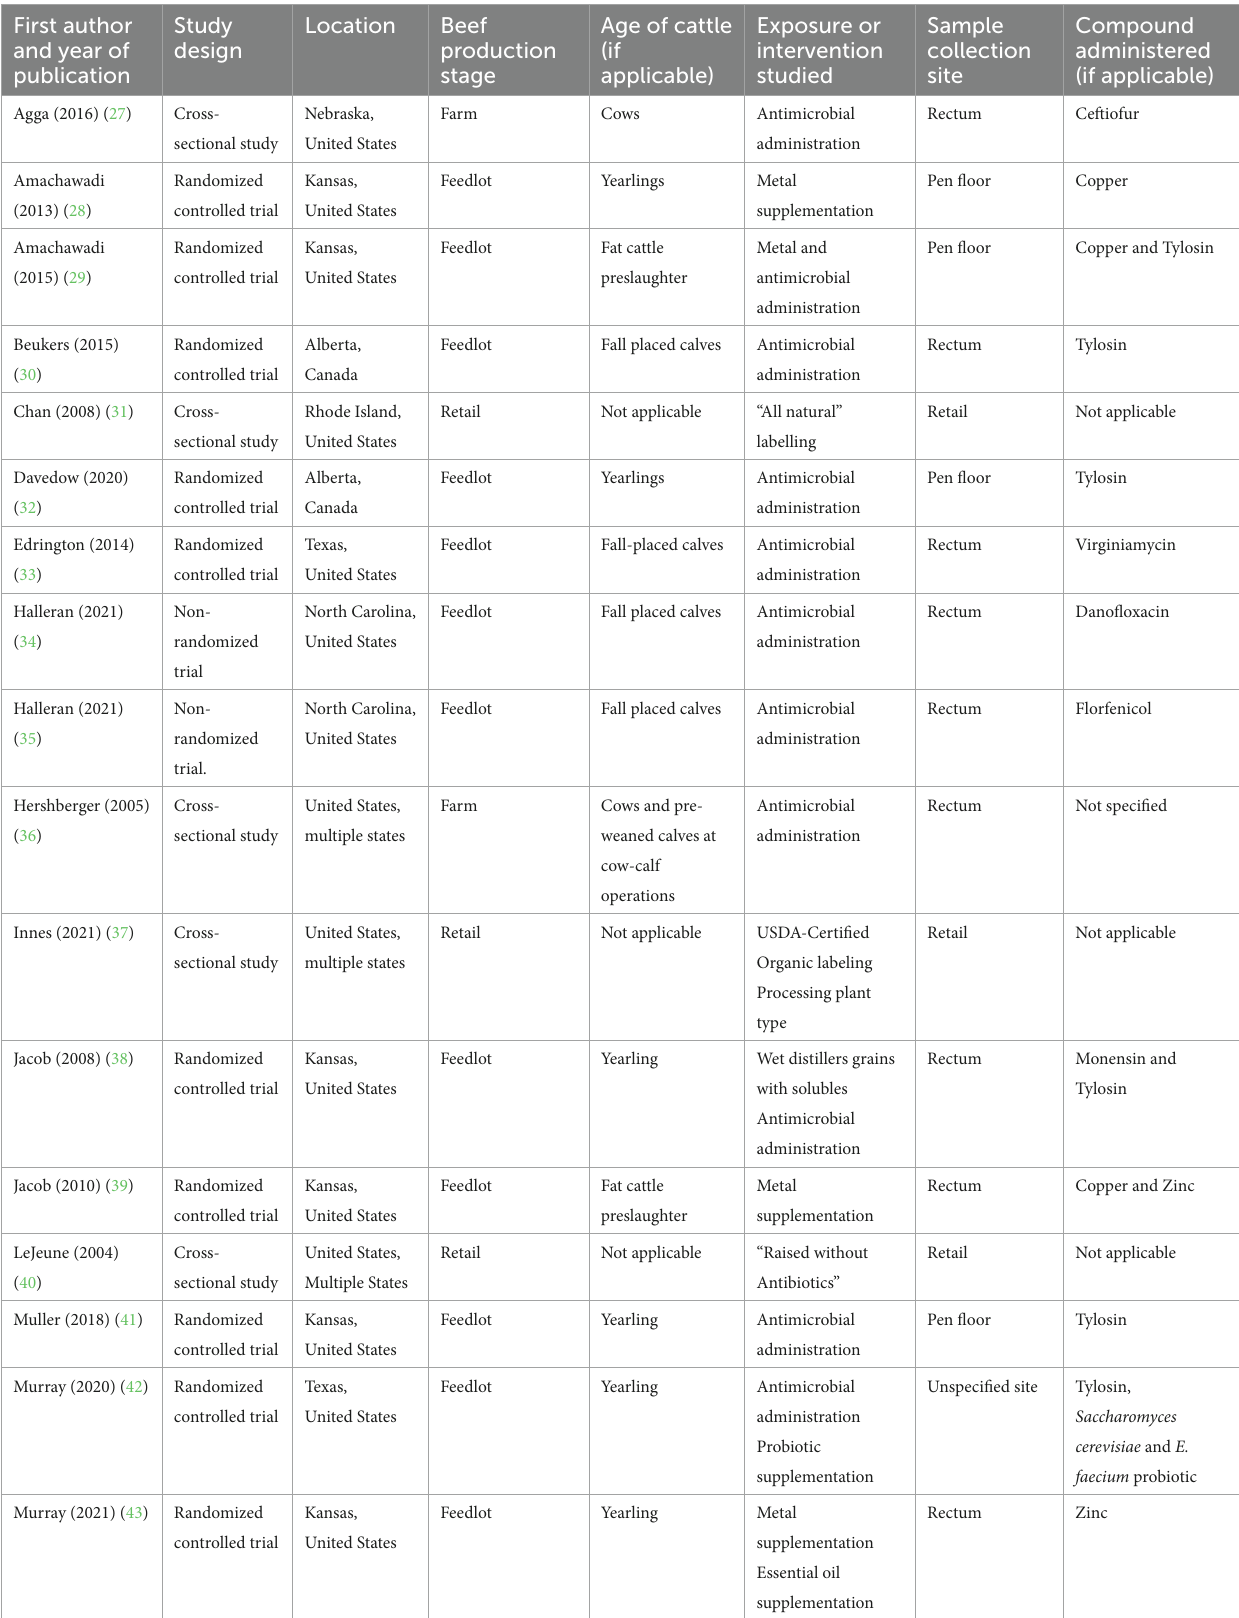
TABLE 1 Summary of the attributes of 26 articles included in the scoping review of reported factors associated with antimicrobial resistant enterococci in Canadian beef